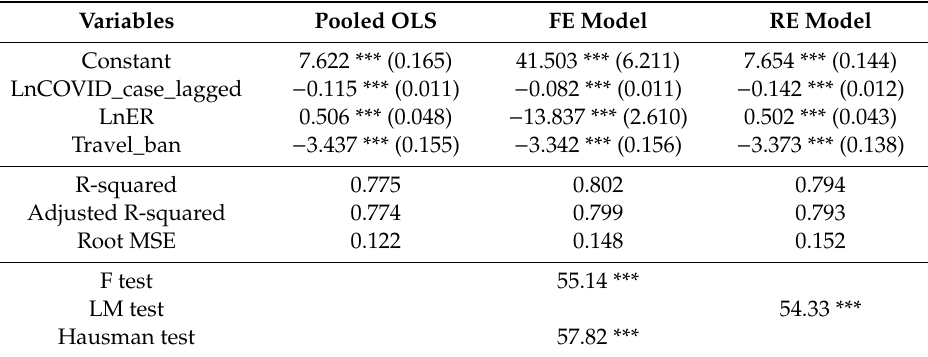
Table 3. Estimation results of panel regression